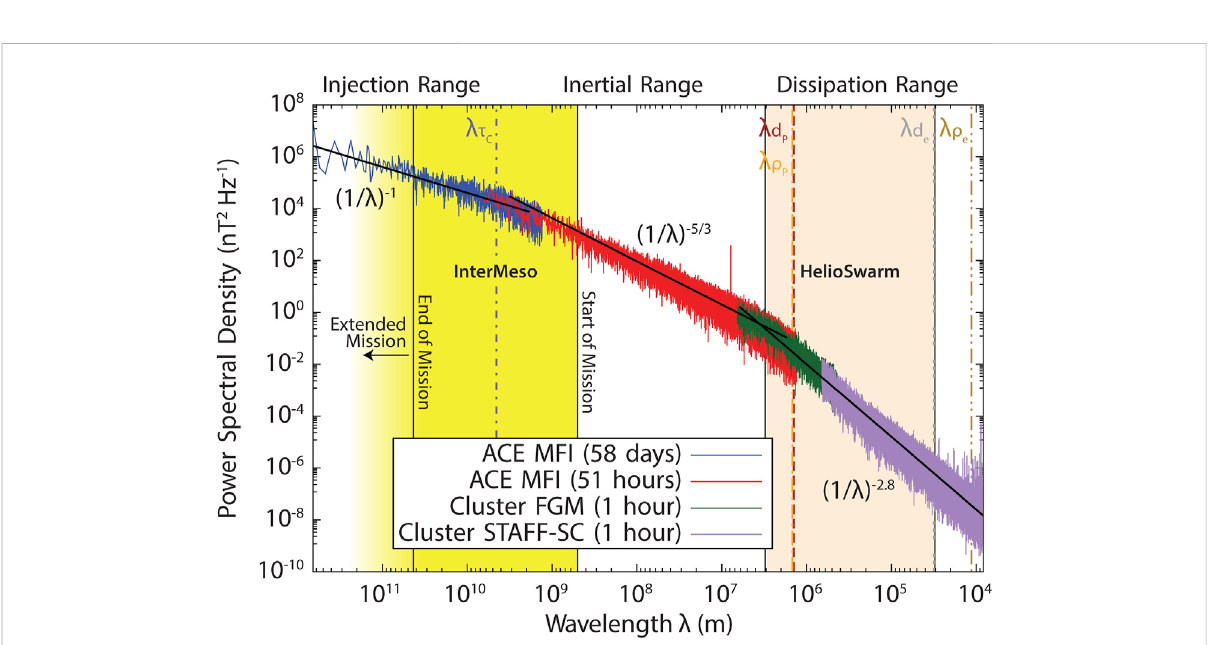
FIGURE 2 Thepowerspectraldensityofmagnetic fi eld fl uctuationsattimeofsolarwindplasmabetanear1aushowstwospectralbreaks(seeVerscharen et al., 2019). The injection range is characterized by a power spectral density slope of (1/ λ ) − 1 , while the inertial range has a slope of (1/ λ ) − 5/3 in the spacecraft frame. The critical frequencies marked are the correlation length (f τ c ), proton inertial length (f dp ) and ion-gyro scale (f ρ p ), and the electron inertial length (f de ) and electron-gyro scale (f ρ e ). While the upcoming HelioSwarm mission will explore the transition between the inertial and dissipation ranges (tan region), InterMeso, for the fi rst time, will reveal the spatiotemporal dynamics between the injection and inertial range (yellow region). Adapted from Verscharen et al.